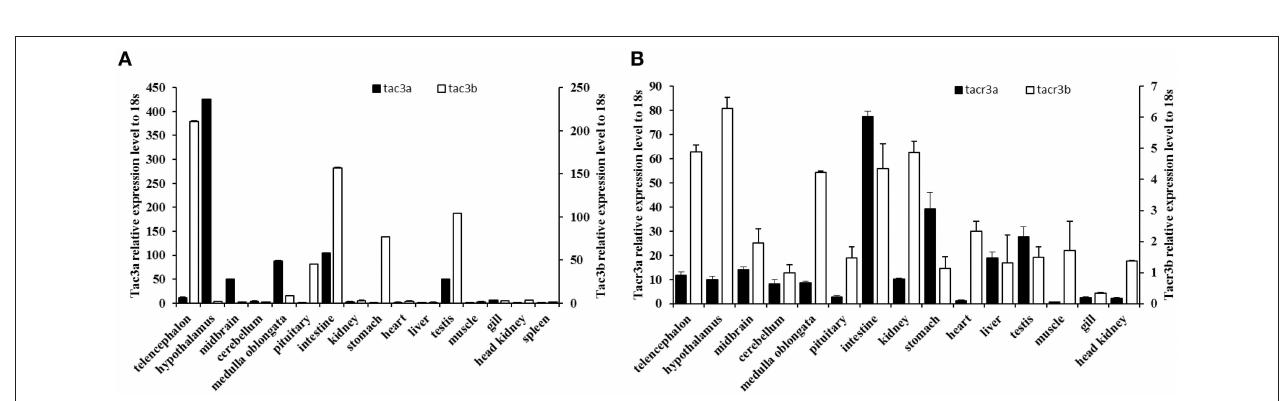
FIGURE 4 | Phylogenetic analysis of the tac (A) and tacr (B) gene family in vertebrates. The phylogenetic tree was constructed by MEGA 6 using the neighbor-joining method. Data were resampled with 1,000 bootstrap replicates.